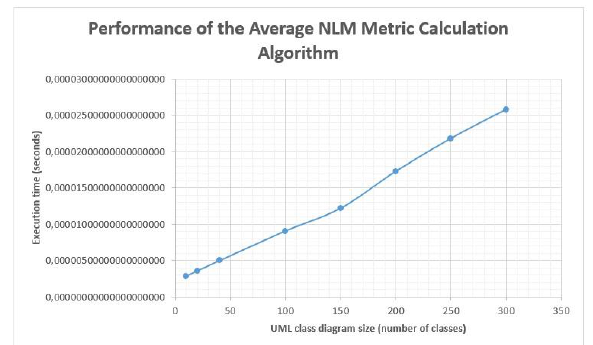
Fig. 8. Performance of the Average NLM Metric Calculation Algorithm